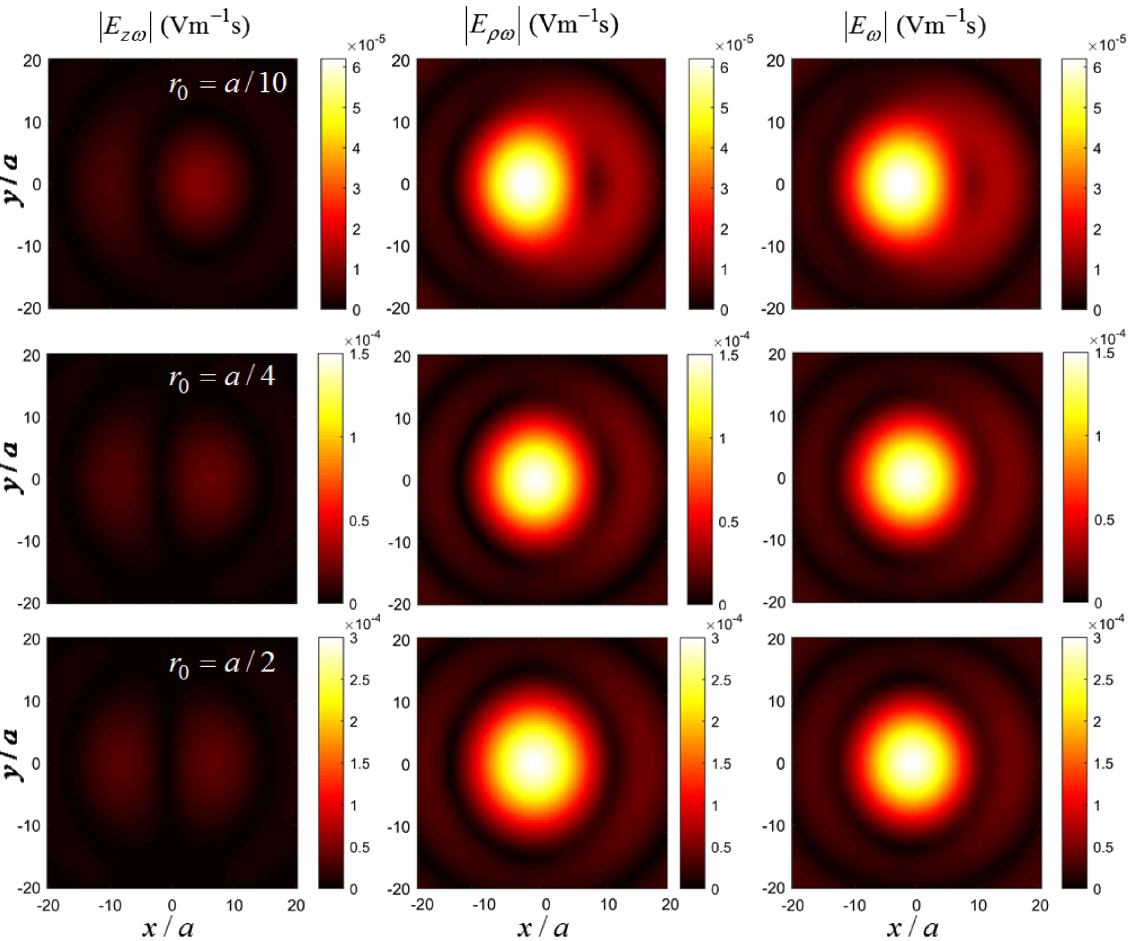
FIG. 4. Two dimensional distribution of absolute values of longitudinal ( E focal plane of the concentrator ( z ¼ 0 ) for three values of charge ’ s shift r 0 ¼ a= 10 ; a= 4 ; a= 2 . Calculation parameters are given